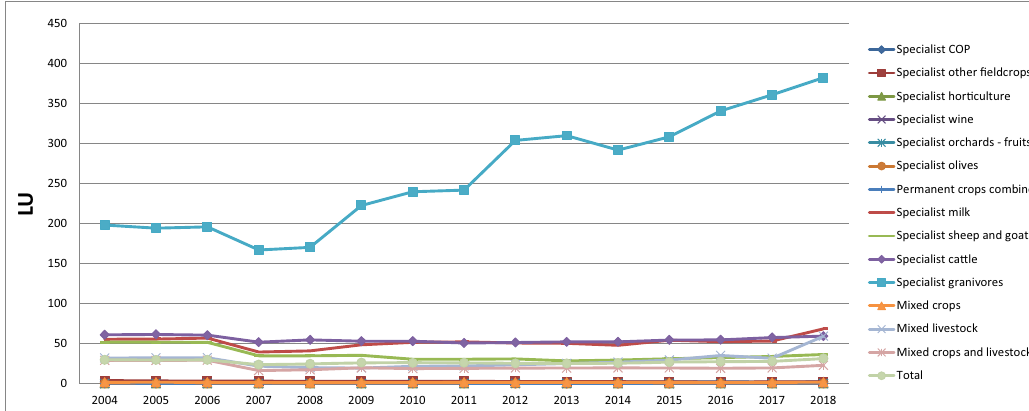
Figure 3: Total livestock units ( LU ) , per farm, for the farm types, for the period 2004 – 2018.